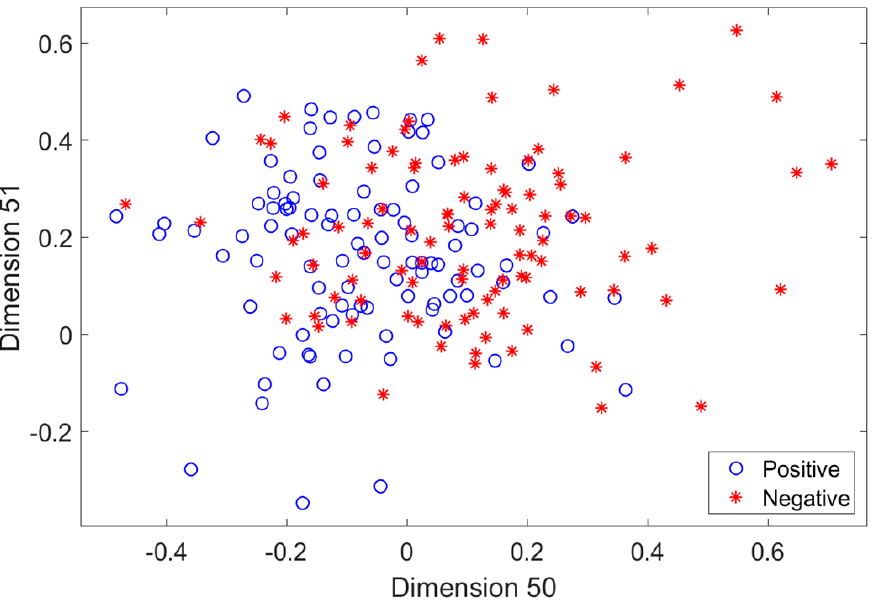
Figure 4. The original training set embedding distribution of the IMDB Dataset for two randomly selected dimensions (100 observations in total). For clear illustration, only the first 100 vectors are plotted.